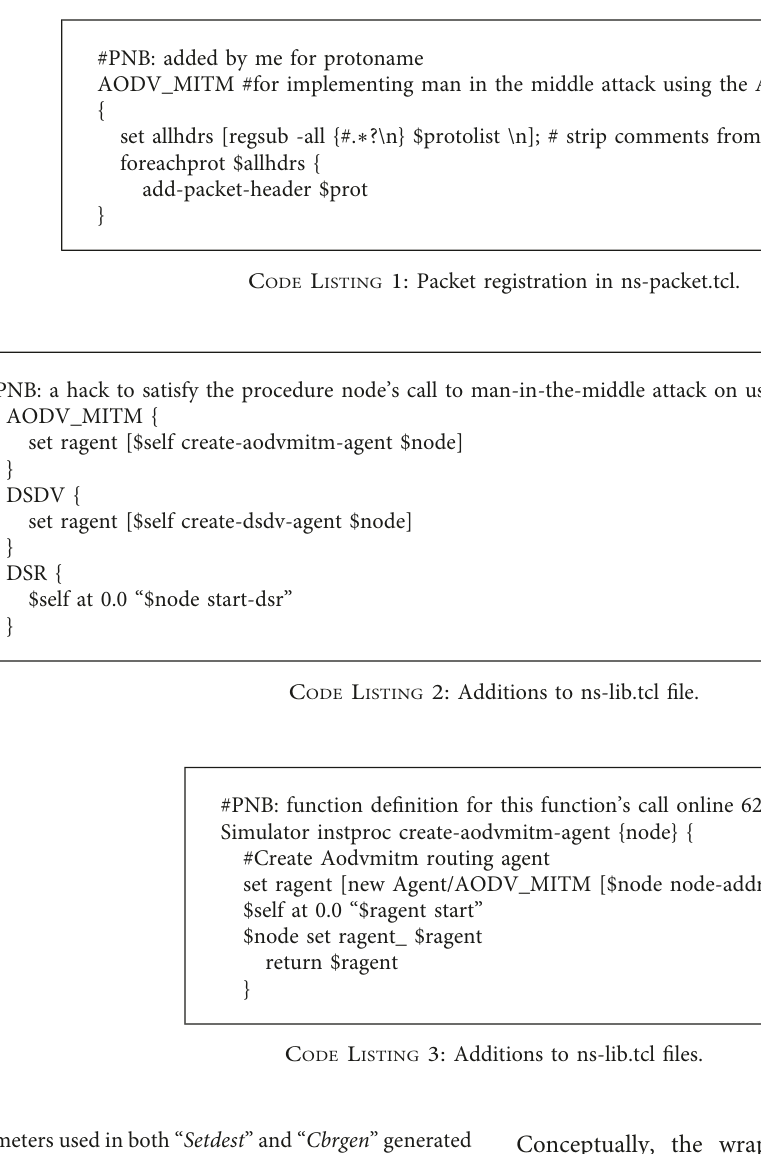
Table 1: Parameters used in both “ Setdest ” and “ Cbrgen ” generated files. “Setdest” generated parameters for